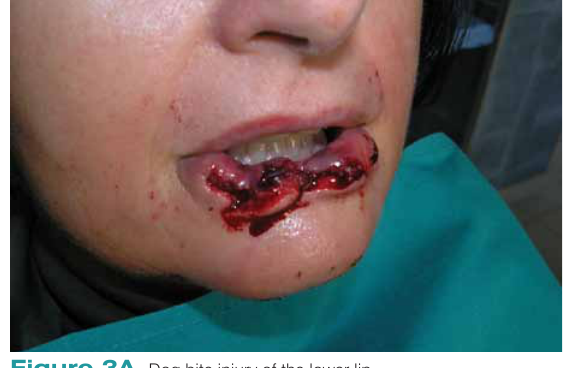
Figure 3A. Dog bite injury of the lower lip